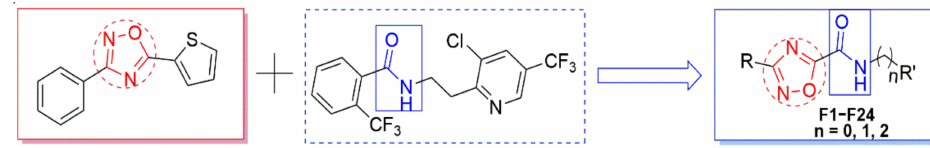
Figure 2. Design of the target compounds.